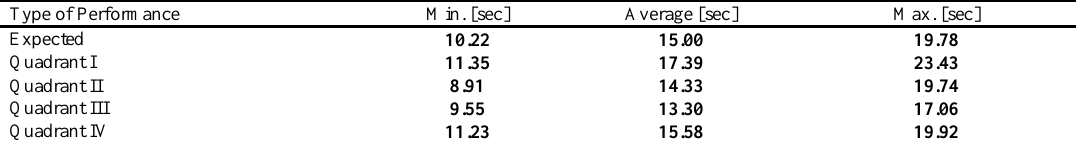
Table 2. Time distributions calculated for each performance class (triangular distribution) Type of Performance